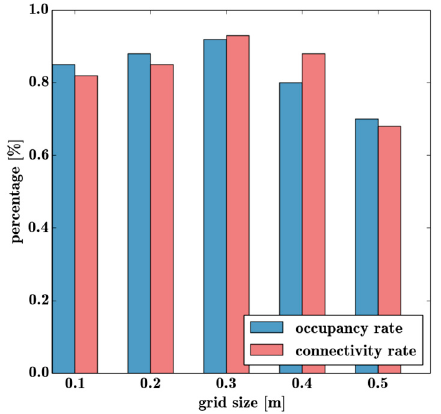
Figure 9. The impact of map resolution on topological map construction.